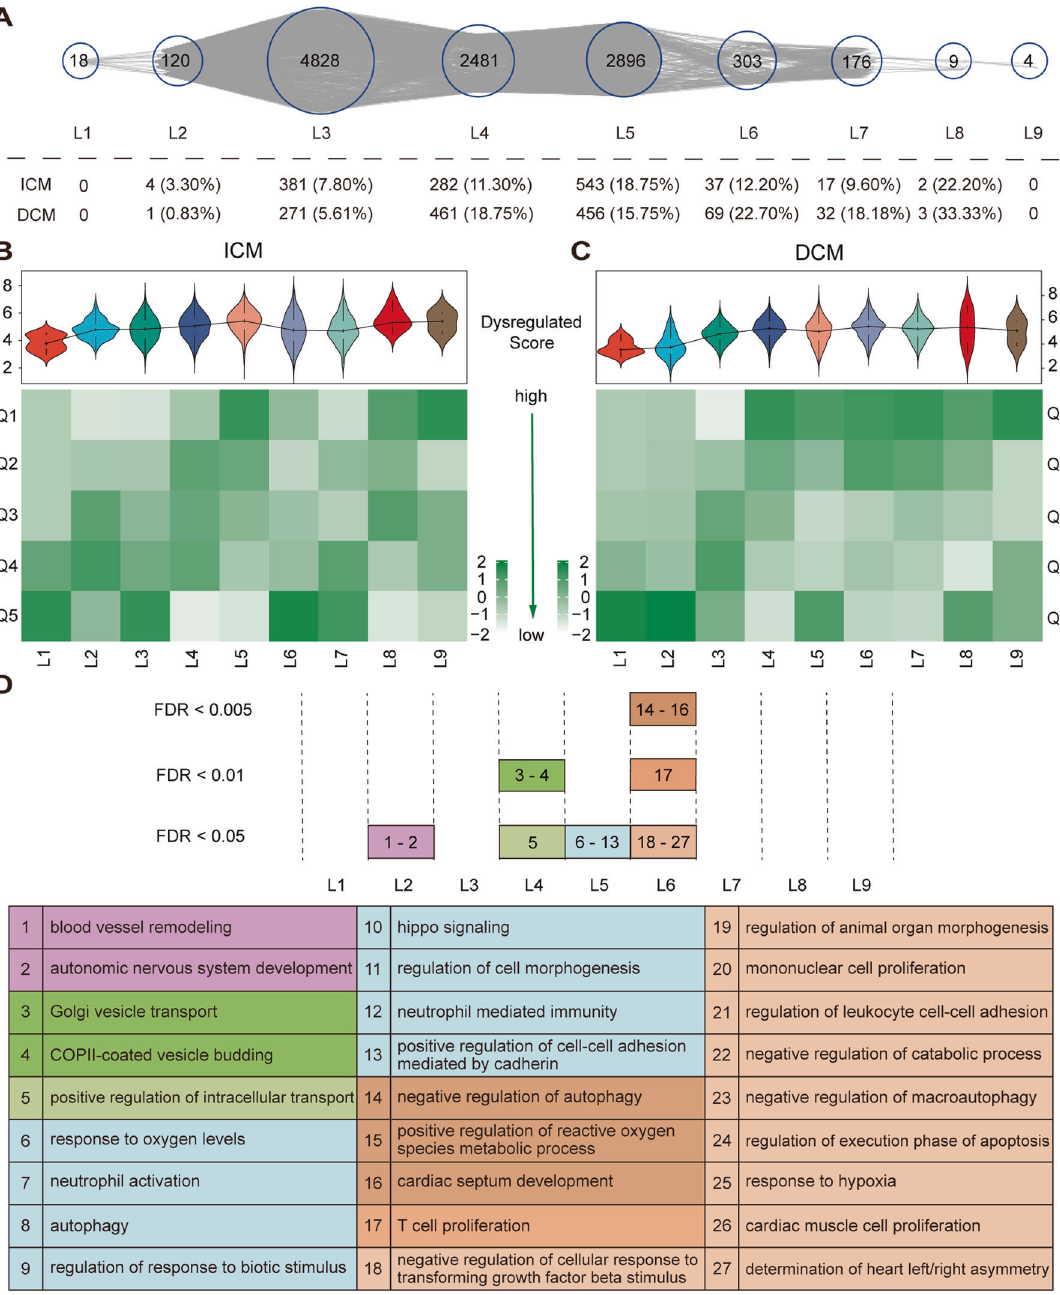
Fig. 2 The constructed TO-BCeN and validation of its rationality. A Global landscape of the TO-BCeN and summary of dysregulated LMM- CTs for ICM and DCM in the TO-BCeN. L1 – L9 represents time-ordered levels for the TO-BCeN. The numbers presented in circles indicate the number of LMM-CTs at a particular level. The numbers inside and outside of the parentheses denote the number and proportion of dysregulated LMM-CTs at the corresponding level, respectively. B , C The violin diagrams and heatmaps of the dysregulated score distribution of LMM-CTs among nine time-ordered levels for ICM and DCM, respectively. For each level in the heatmap, dysregulated scores were divided equally into fi ve parts, and the number of LMM-CTs in each part was computed. The color of the square denotes the corresponding standard score. D Signi fi cantly enriched biological functions for mRNAs in ICM dysregulated LMM-CTs at each time-ordered level are shown. The numbers in the plot (Top) corresponded to the index number of signi fi cantly enriched functions listed in the table (Bottom). The pink, green, blue, and orange colors represent the stages of vascular dysfunction, signal transport, responses after myocardial ischemia and myocardial remodeling,